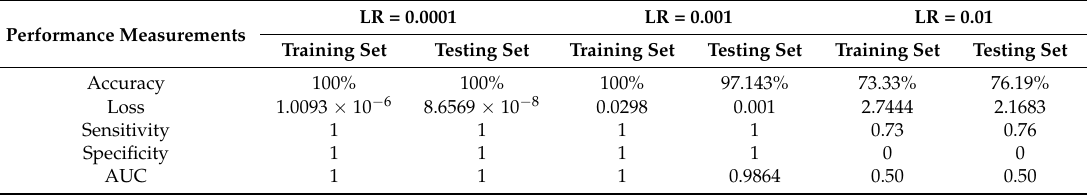
Table 2. Performance of AlexNet with Lr = [0.0001, 0.001, 0.01].